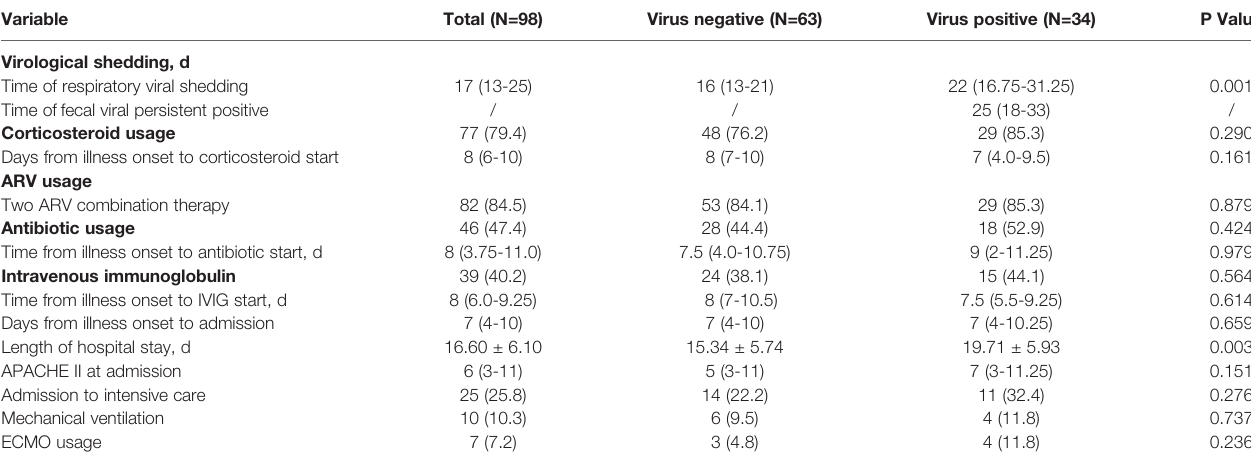
TABLE 2 | Treatment and Outcome of 99 Hospitalized Patients With SARS-CoV-2 Infection. Variable Virological shedding, d Time of respiratory viral